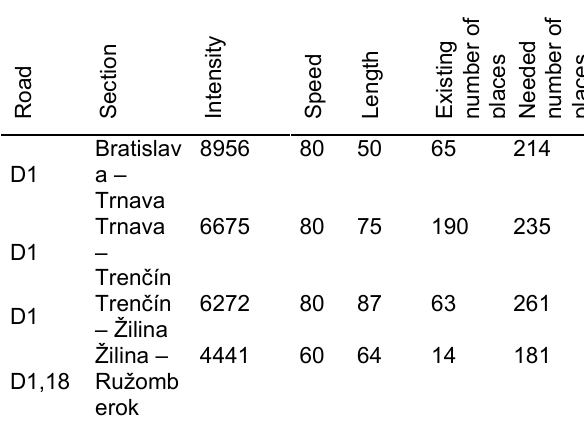
Table 2. Needed number of parking places in selected sections of road